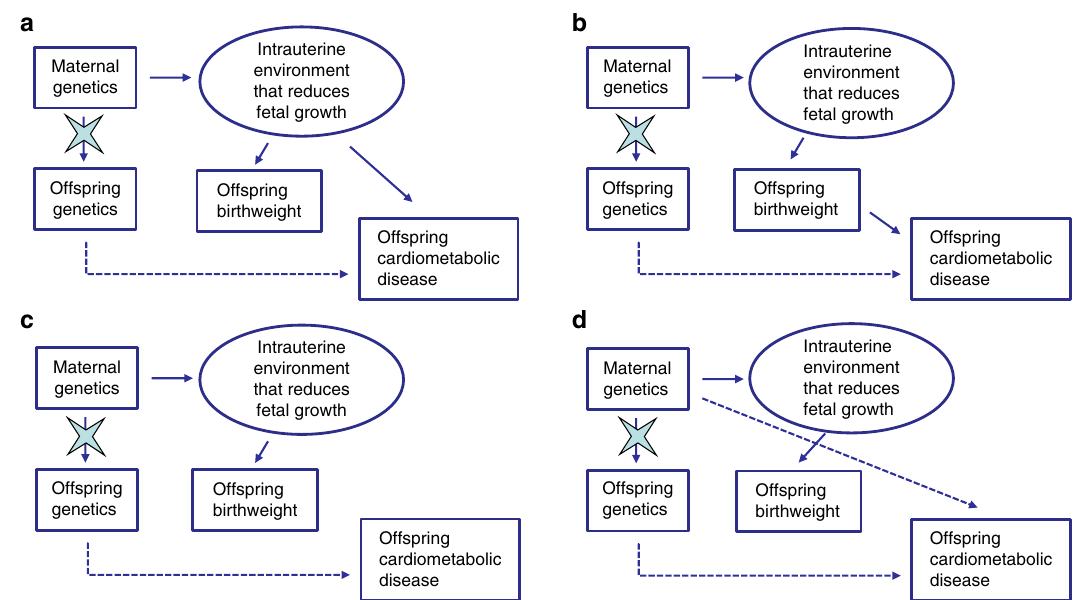
Fig. 1 Four credible ways in which maternal single nucleotide polymorphism (SNP)s can be related to offspring birthweight and offspring cardiometabolic risk factors. a Maternal SNPs produce an adverse in utero environment that leads to fetal growth restriction and subsequently low offspring birthweight and developmental compensations that produce increased risk of offspring cardiometabolic disease in later life. b Maternal SNPs produce an adverse in utero environment that leads to fetal growth restriction and low offspring birthweight. Low offspring birthweight in turn is causal for increased risk of offspring cardiometabolic disease. c Maternal SNPs produce an adverse in utero environment that leads to fetal growth restriction and reduced birthweight. The same SNPs are transmitted to the offspring and pleiotropically in fl uence offspring cardiometabolic risk through the offspring genome. d Maternal SNPs produce an adverse in utero environment that leads to fetal growth restriction and reduced offspring birthweight. SNPs that